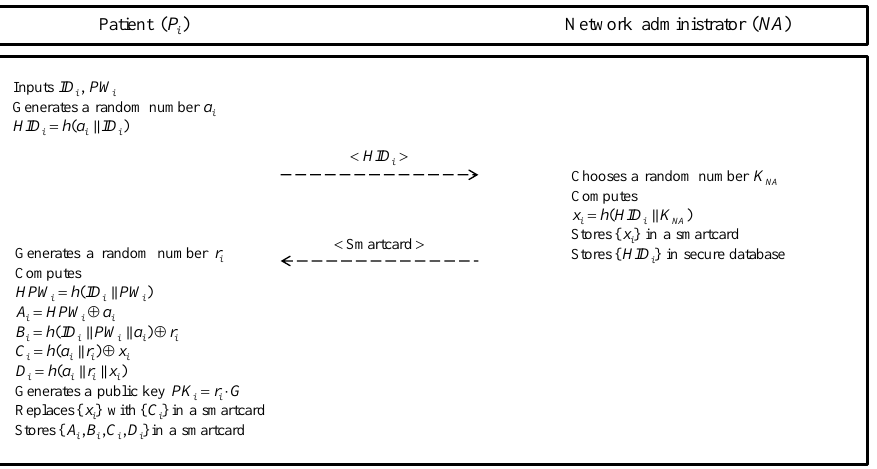
Figure 2. Patient registration phase of the proposed protocol.